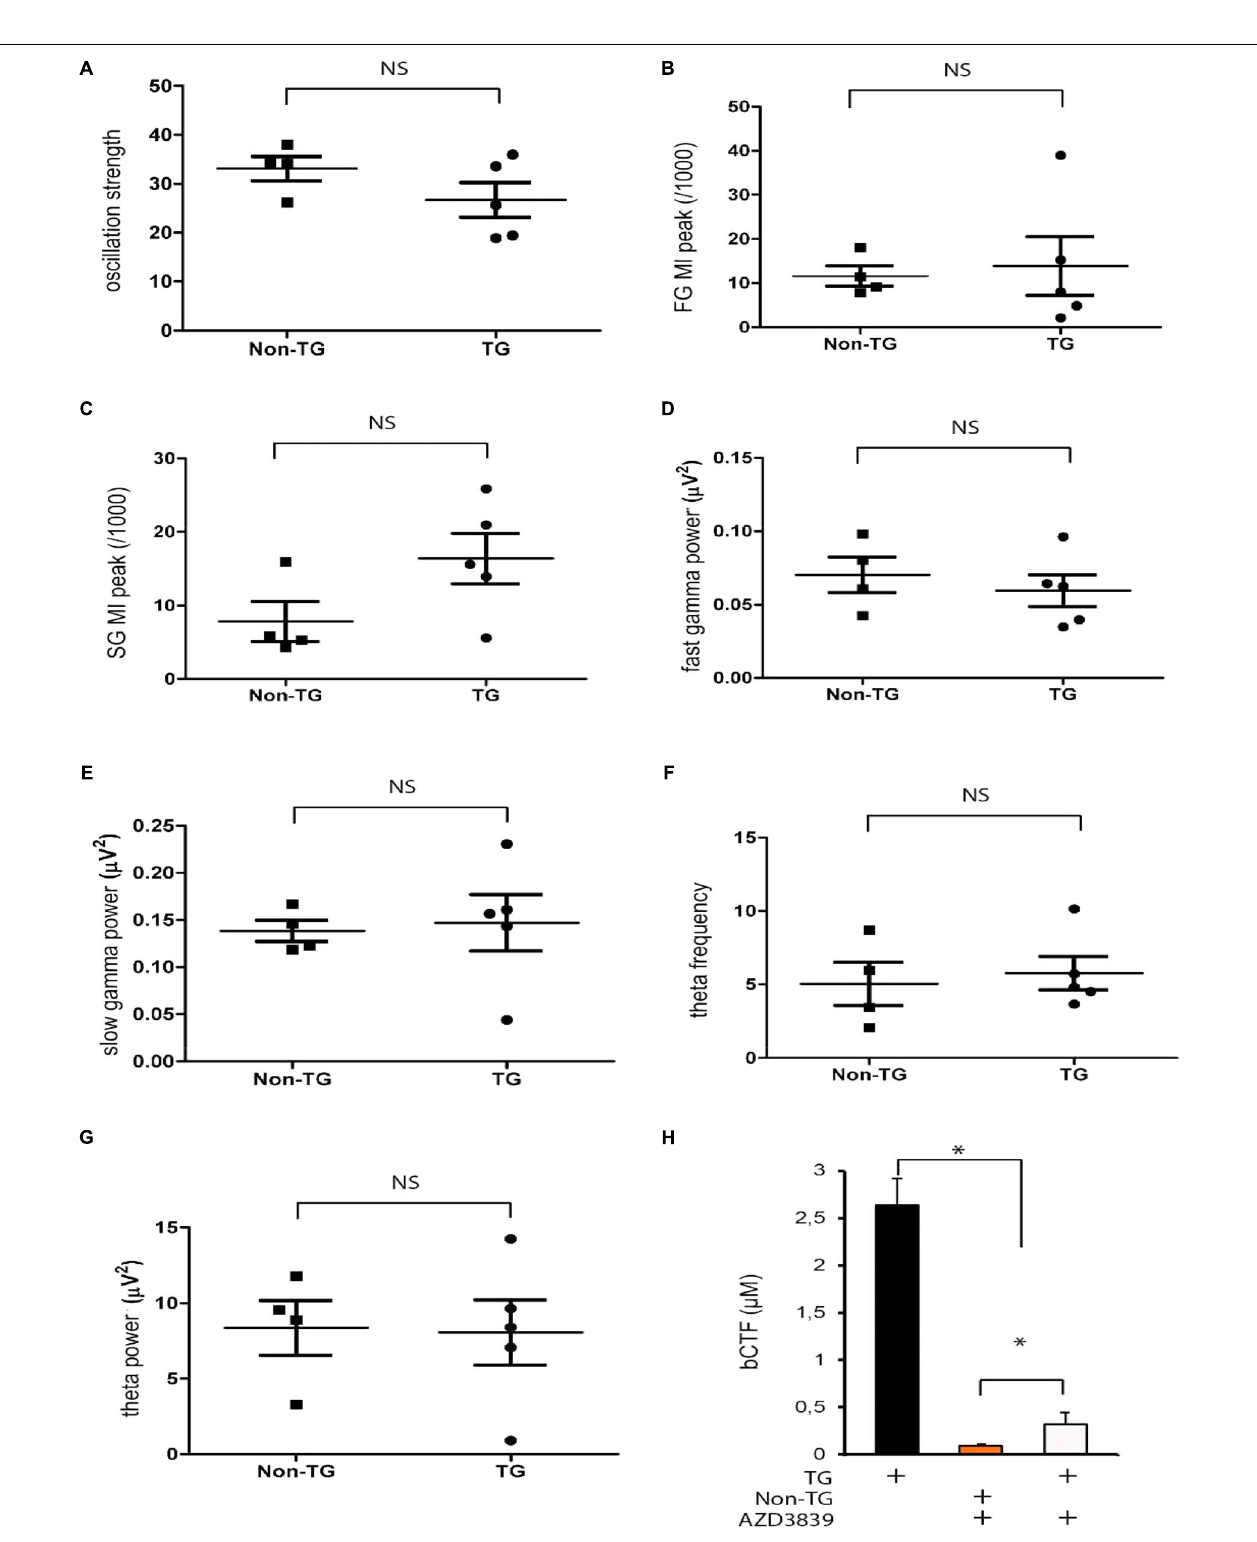
FIGURE 8 | AZD3839 prevents b-CTF accumulation and rescues the abnormal phenotype in J20 mice. In J20-TG mice IP administrated AZD3839 rescues the theta strength alterations (A) . Theta-gamma CFC at slow (25–45 Hz) and fast (150–250 Hz) gamma range is also rescued in J20-TG treated mice (B–E) . Treated J20-TG mice did not show detectable changes in either, theta frequency (F) or theta power (G) , NS: p > 0.05. AZD3839 reduced b-CTF accumulation as detected by Elisa essay (H) , ∗ p < 0.005.